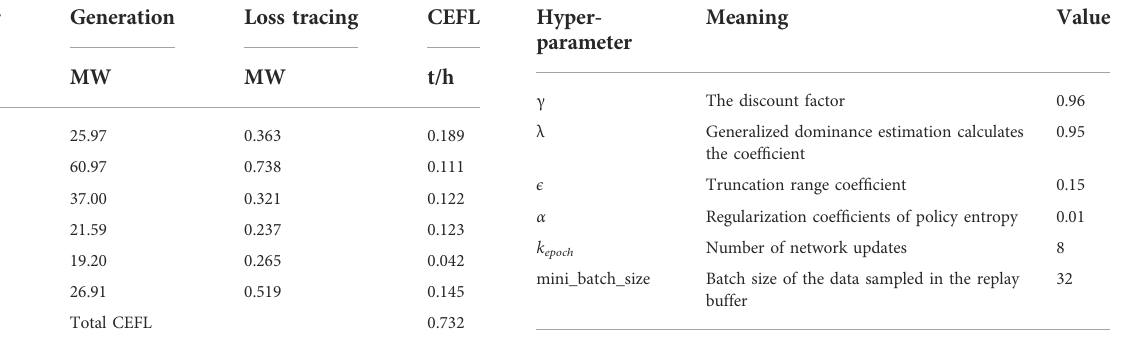
After Before After Before After